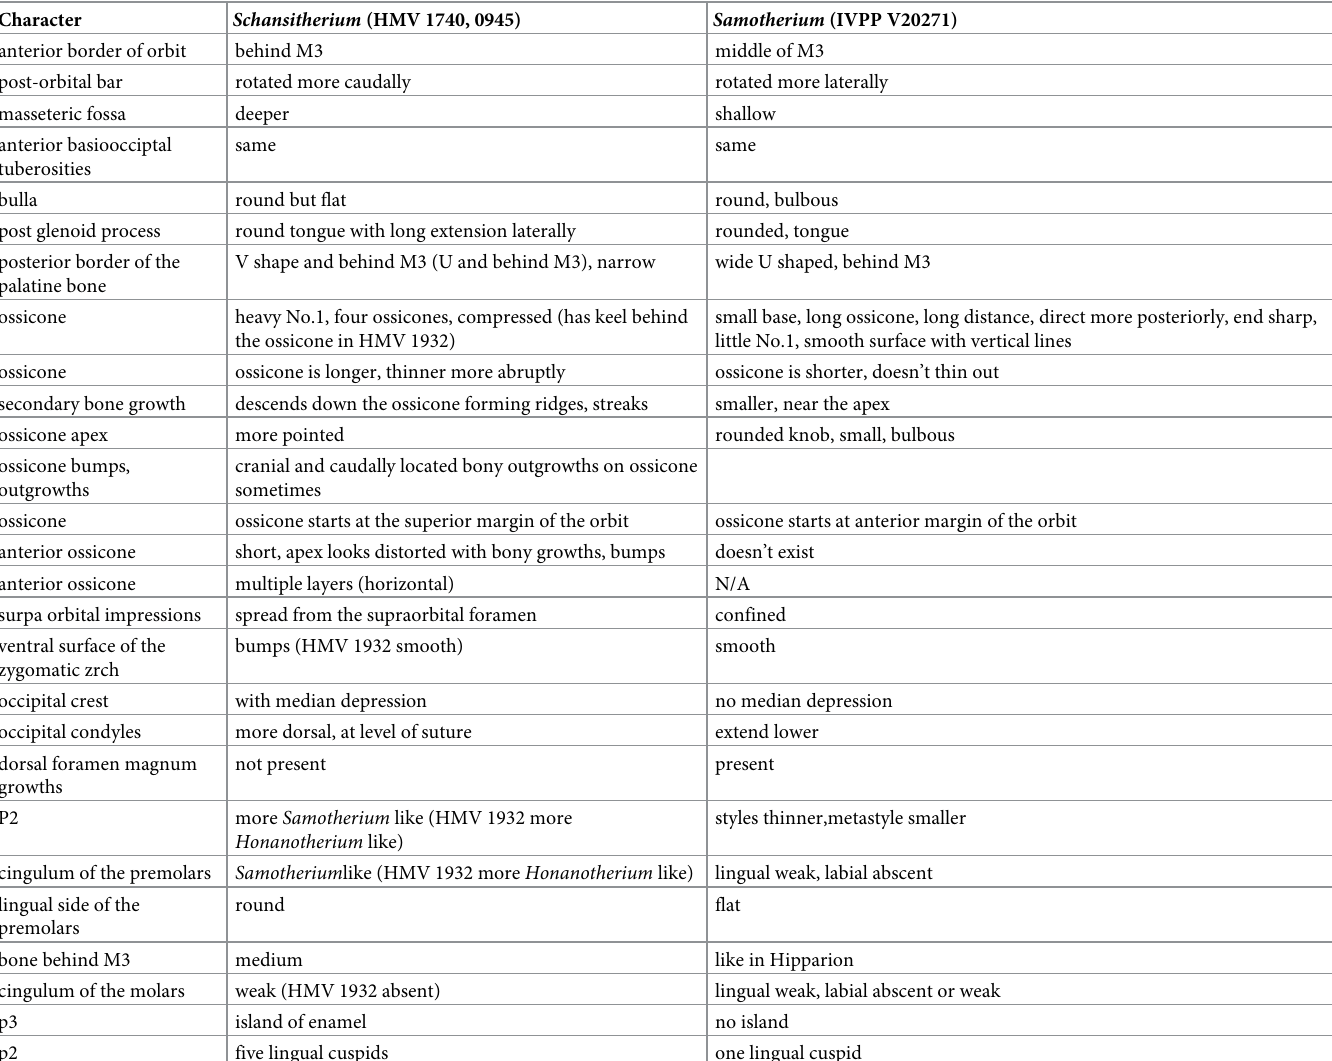
Table 1. Comparisons of Schansitherium tafeli with Samotherium boissieri